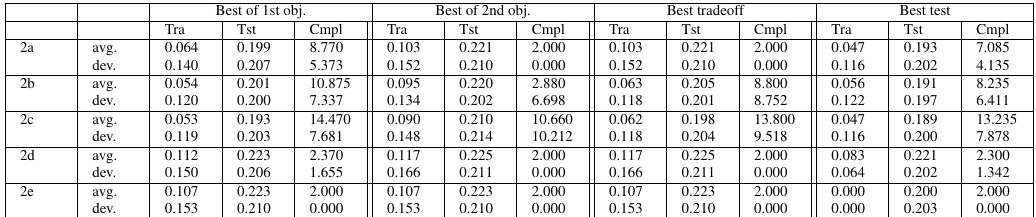
Table 11: A comparison of the averaged performance of the four single solutions selected from the obtained Pareto sets. Bestof1stobj.